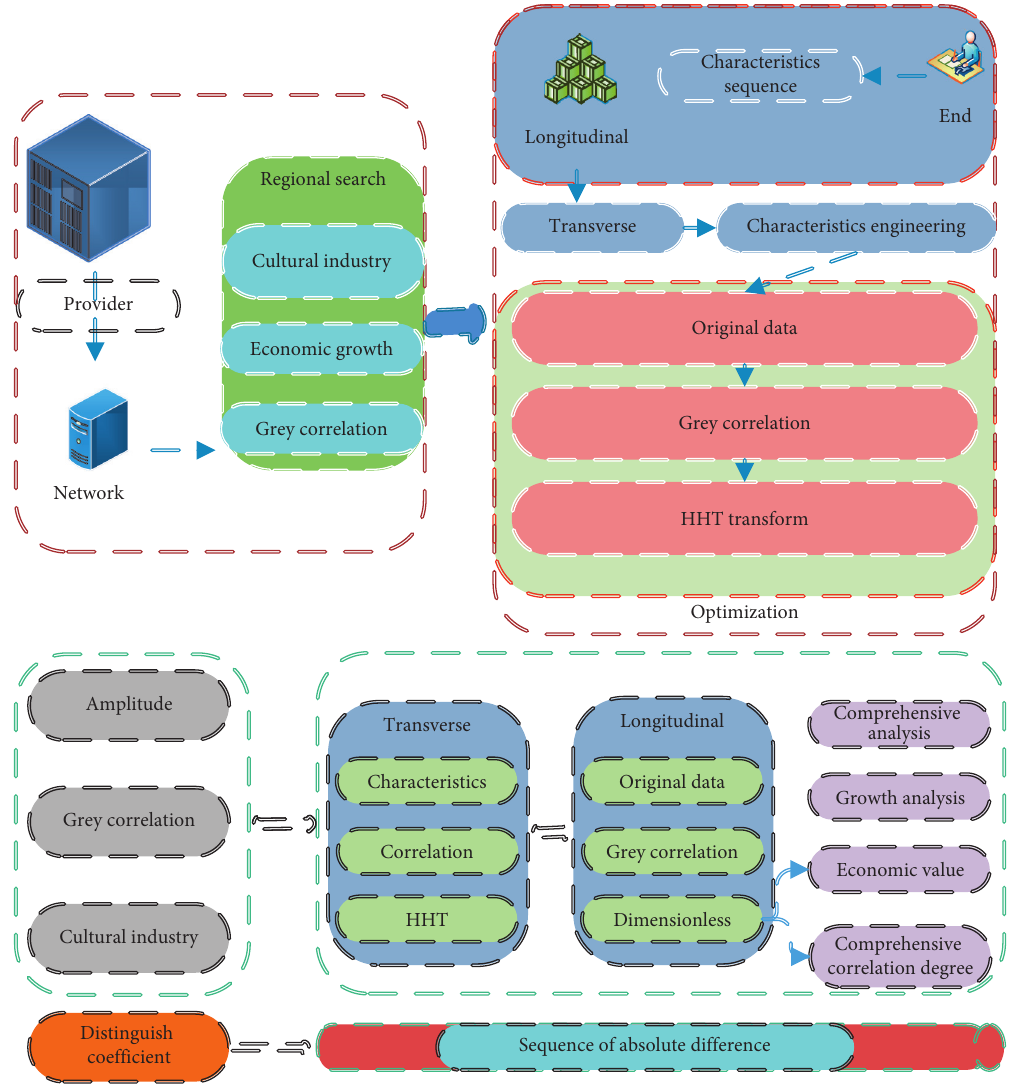
Figure 1: Analysis of cultural industry and economic growth based on grey correlation degree. Table 1: GDP, value added of cultural industry, and value added of three major industries. Reference sequence Comparison sequences